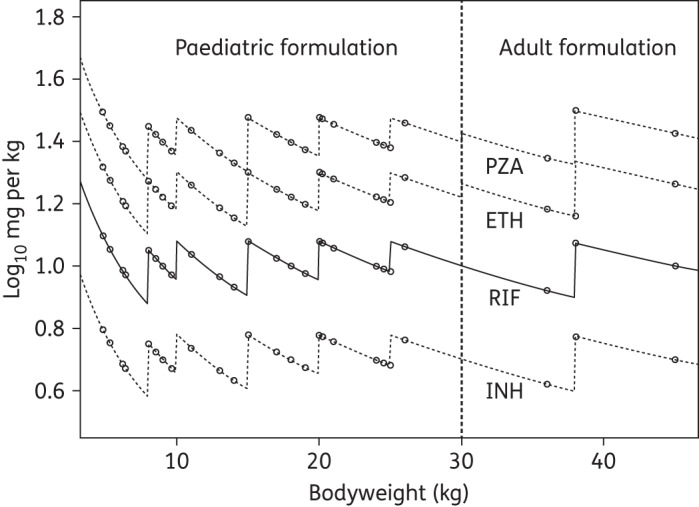
Weight-adjusted dose by weight band for the four drugs in two different formulations. PZA, pyrazinamide; ETH, ethambutol; RIF, rifampicin; INH, isoniazid.